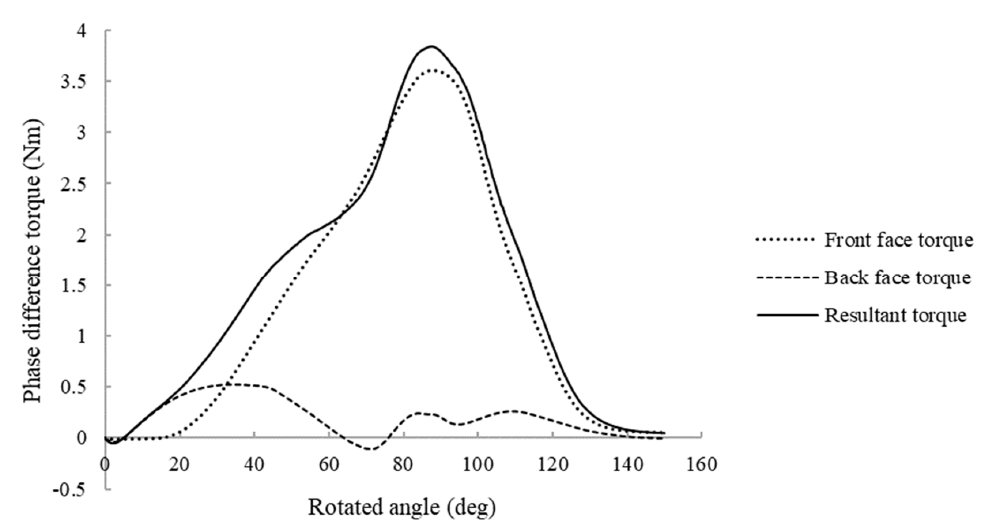
Figure 16. Example of the torque curves generated from a single simulation. Table 4. Attempted design changes and their outcomes.